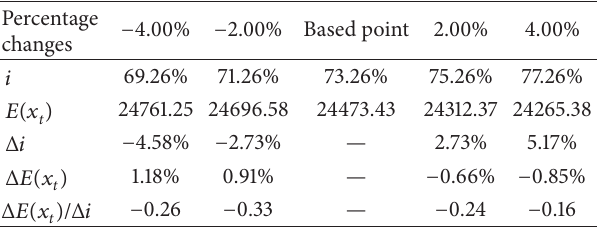
Table 1: The sensitivity analysis of 𝑖